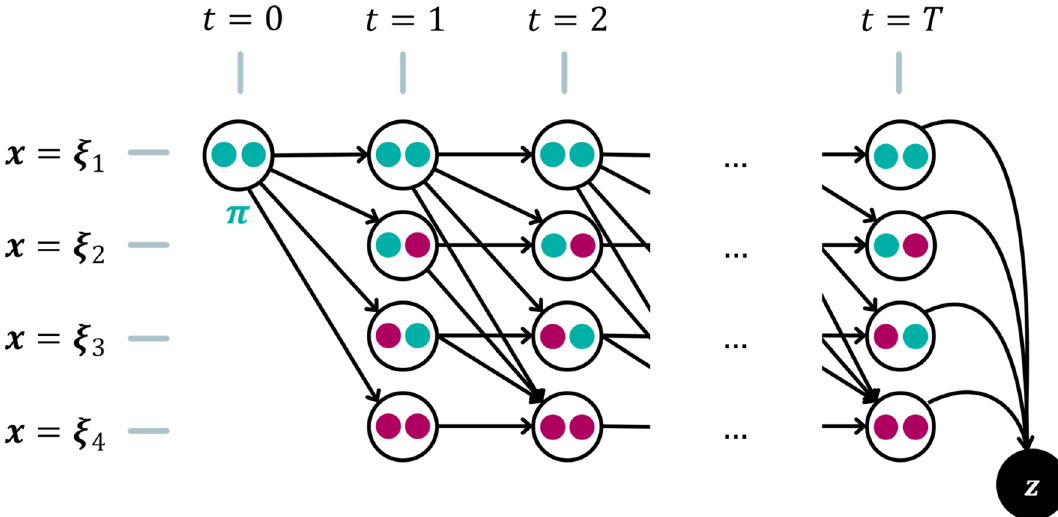
Figure 4. Illustration of possible paths from the starting state ( π ) to a diagnosis ( z ) at time T on a discrete grid of time vs state. Only 4 states (corresponding to 2 LNLs) are shown, where green indicates healthy and purple involved. Following the arrows from π to z yields a possible path. Some connections between states are forbidden due to Q (no self-healing). To calculate the probability of a diagnosis ( z ), we must marginalize over all